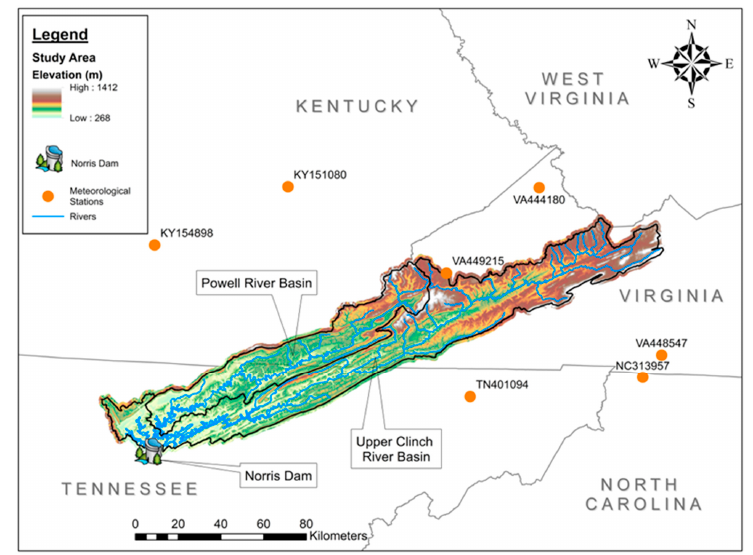
Figure 1. Study area showing Norris Reservoir, Clinch and Powers River Basins, and meteorological stations used in this study.